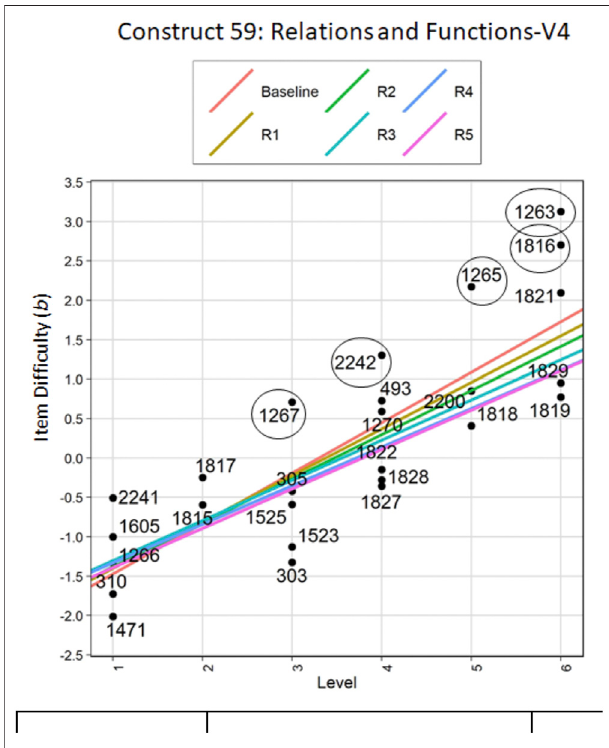
FIGURE 3 | Linear regression of LT level ( x -axis) predicting item dif fi culty ( b , y- axis). Regression lines run sequentially after removing one item based on absolute residual value. Circled items were removed and remained out of the model for subsequent